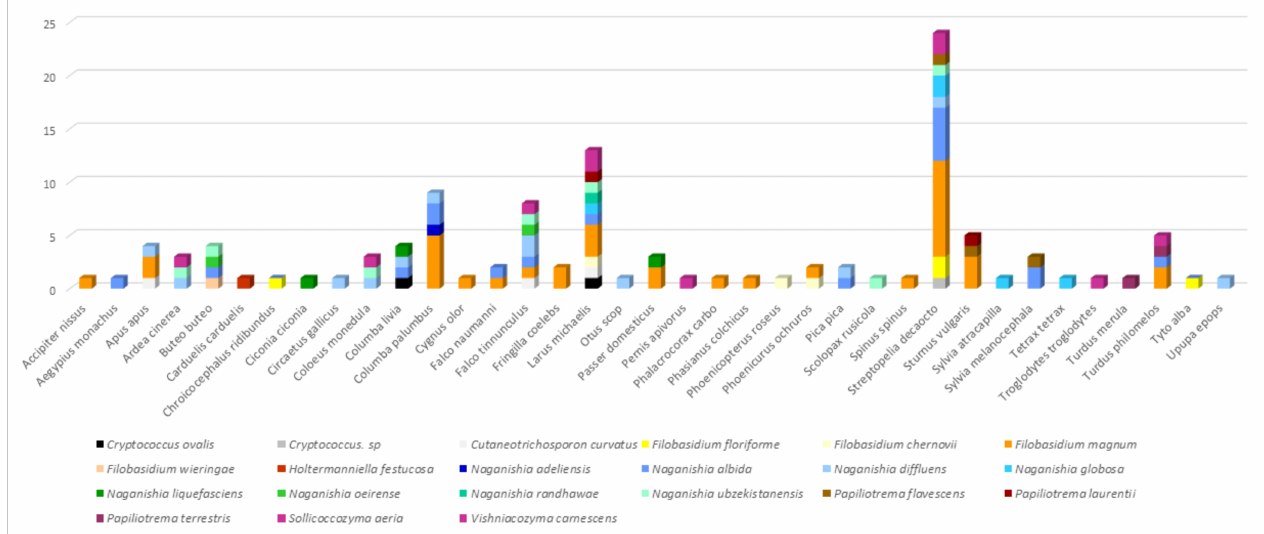
Figure 1. Distribution of Cryptococcus and former Cryptococcus species by bird of